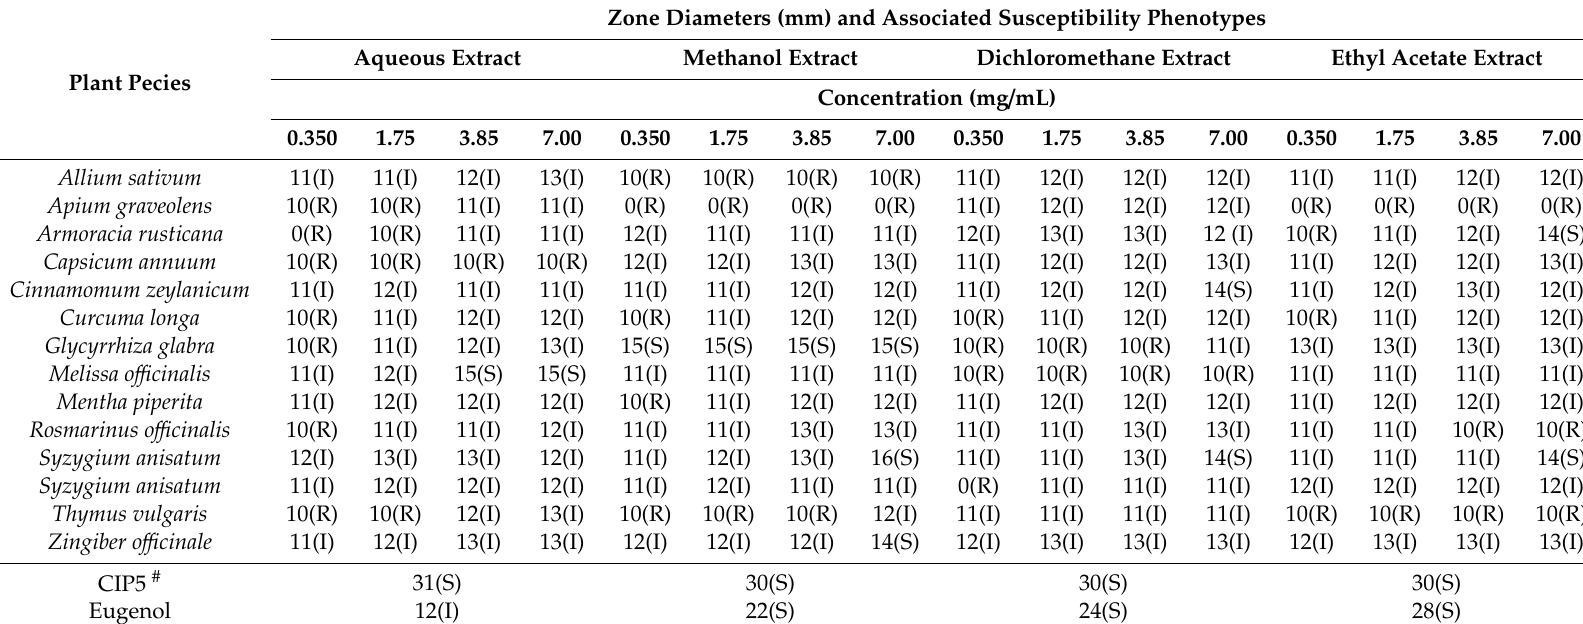
Table 3. Antibacterial activity of a range of concentrations of herbs and spices as determined using the agar well di ff usion method.